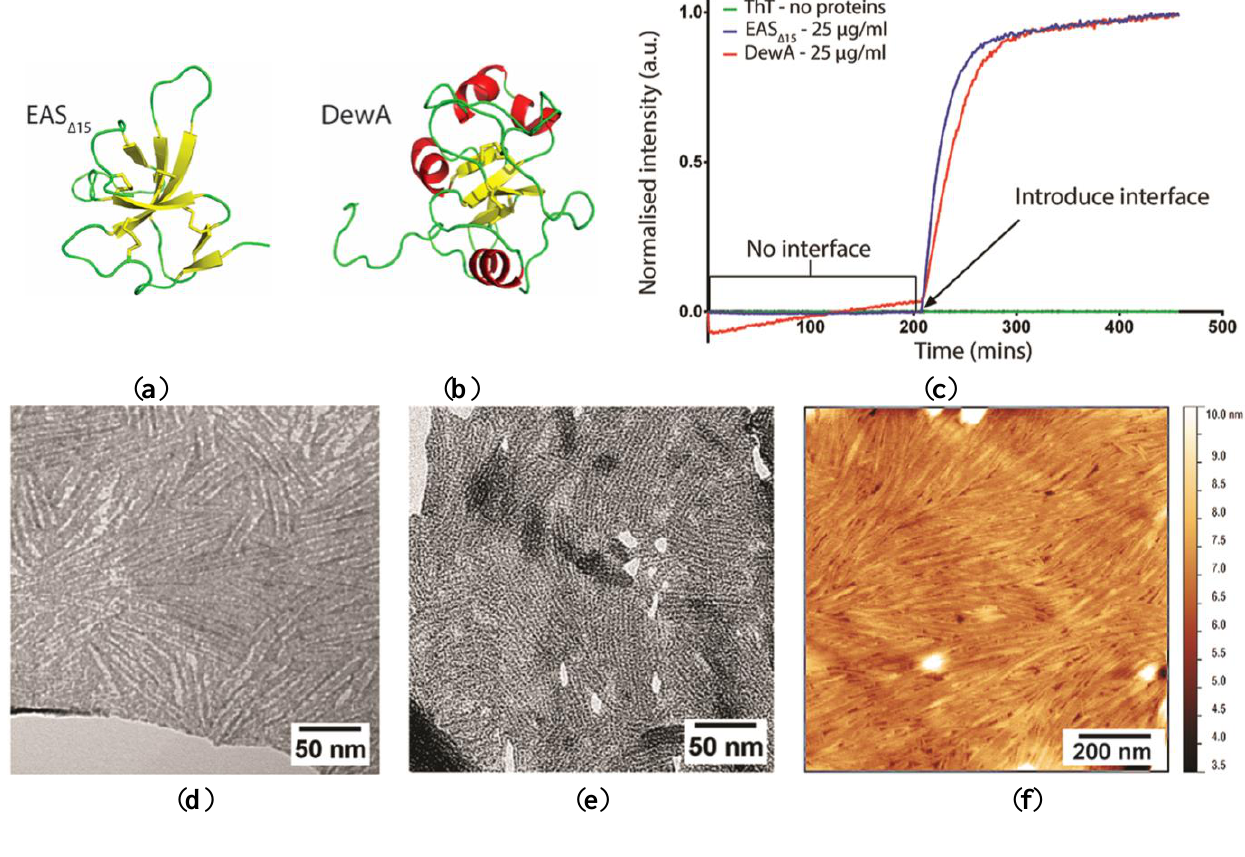
Figure 1. Solution structures of the soluble forms of Class I hydrophobins: ( a ) EAS ( b ) DewA, determined by nuclear magnetic resonance (NMR) spectroscopy.